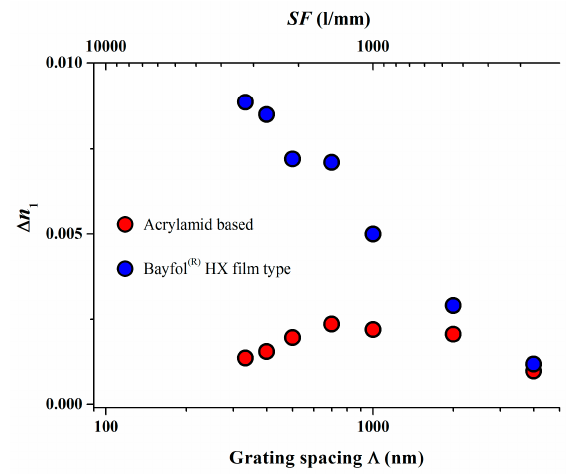
Figure 5. Experimental values of ∆ n 1 (symbols) versus grating spacing Λ (or spatial frequency SF ~ 1/ Λ ) for experimental Bayfol ® HX film type photopolymers in comparison to an acrylamid based photopolymer system [18]. Extracted values for σ 2 are 85 nm 2 for the experimental Bayfol ® HX film type photopolymer and 3840 nm 2 for the acrylamid based photopolymer.